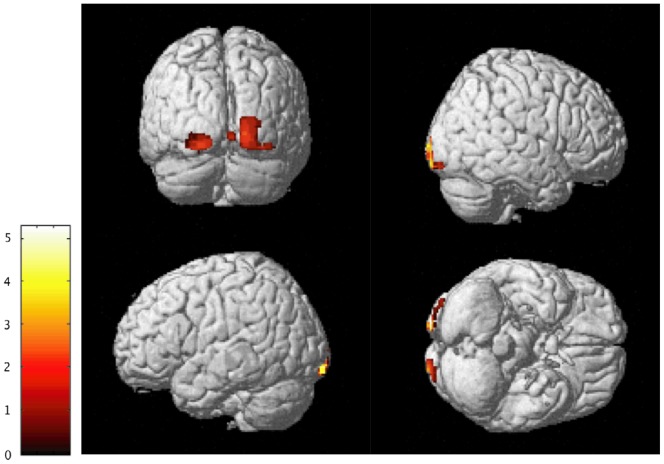
Voxel based morphometry results.Significant differences between subjects exposed to high levels of WDV and unexposed controls. Significantly decreased gray-matter densities in WDV subjects were measured in the right and left lingual gyrus (BA18). Color scale: 0–5 represent t-values.